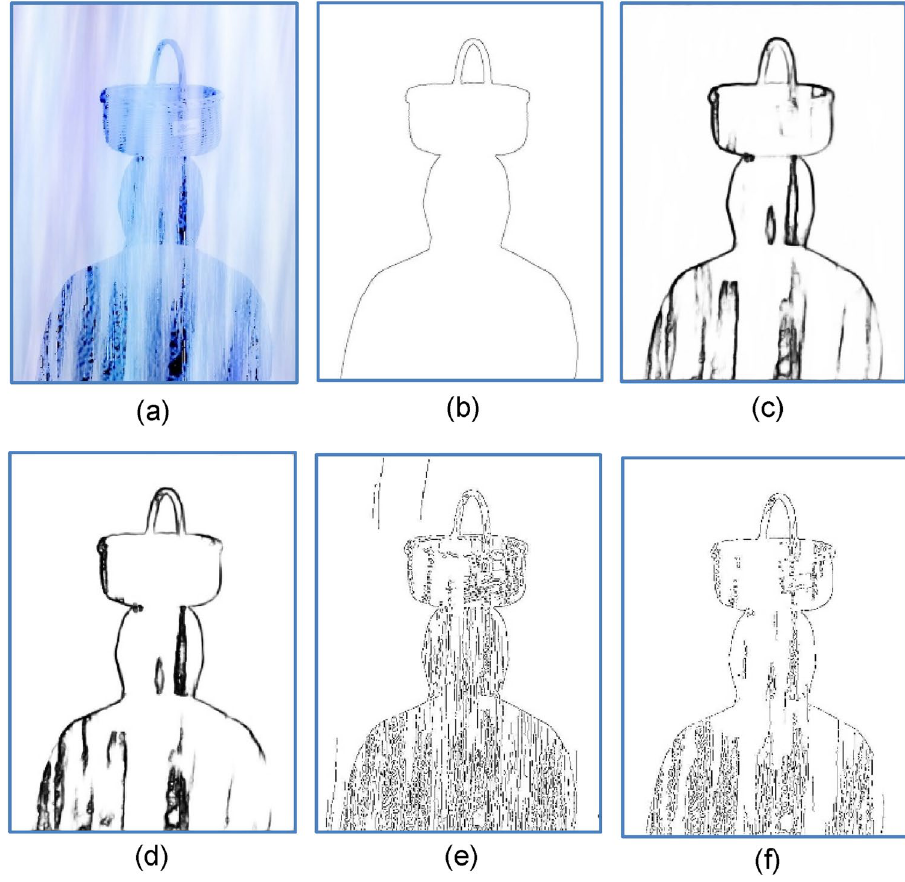
Figure 15. Failure case ( a ) Test image ( b ) GT(ground truth) ( c ) RCF, (MQ, EQ, FoM) = (0.09, 0.05, 0.18). ( d ) HED, (MQ, EQ, FoM) = (0.08, 0.04, 0.16). ( e ) Canny with H t = 0.1 , (MQ, EQ, FoM) = (0.05, 0.02, 0.06). ( f ) our method, (MQ, EQ, FoM) = (0.07, 0.04,